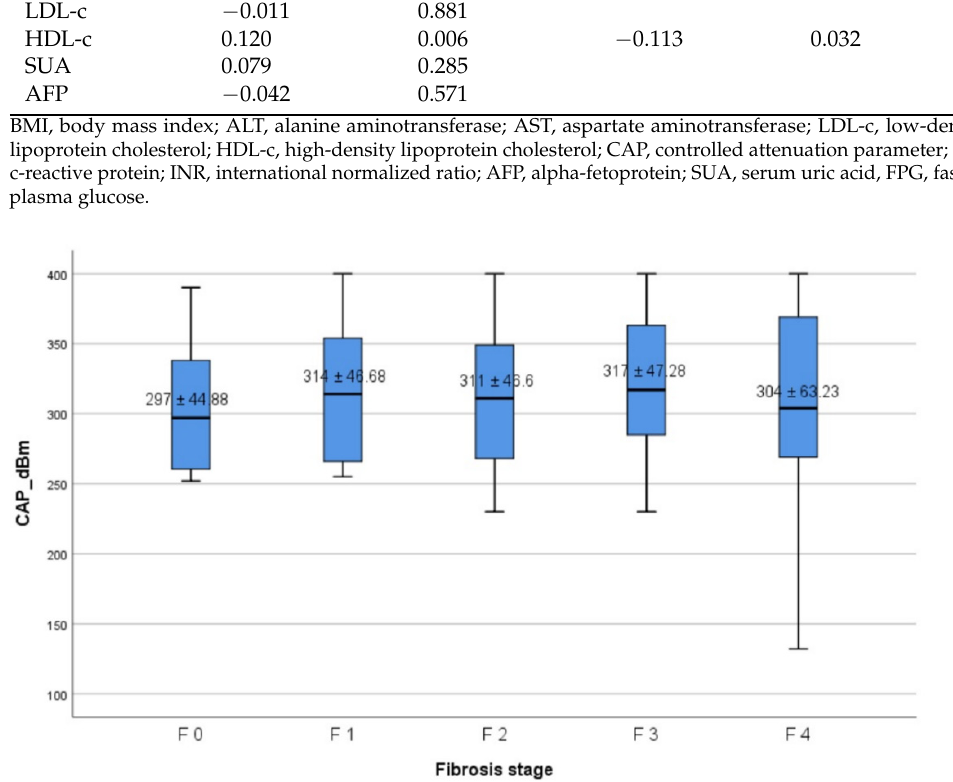
Figure 2. CAP values according to fibrosis stages. The bottom and the top of each box represent the 25th and 75th percentiles, while the lines through the box indicate the median. Table 5. Comparison of LSM and CAP values according to fibrosis stages.